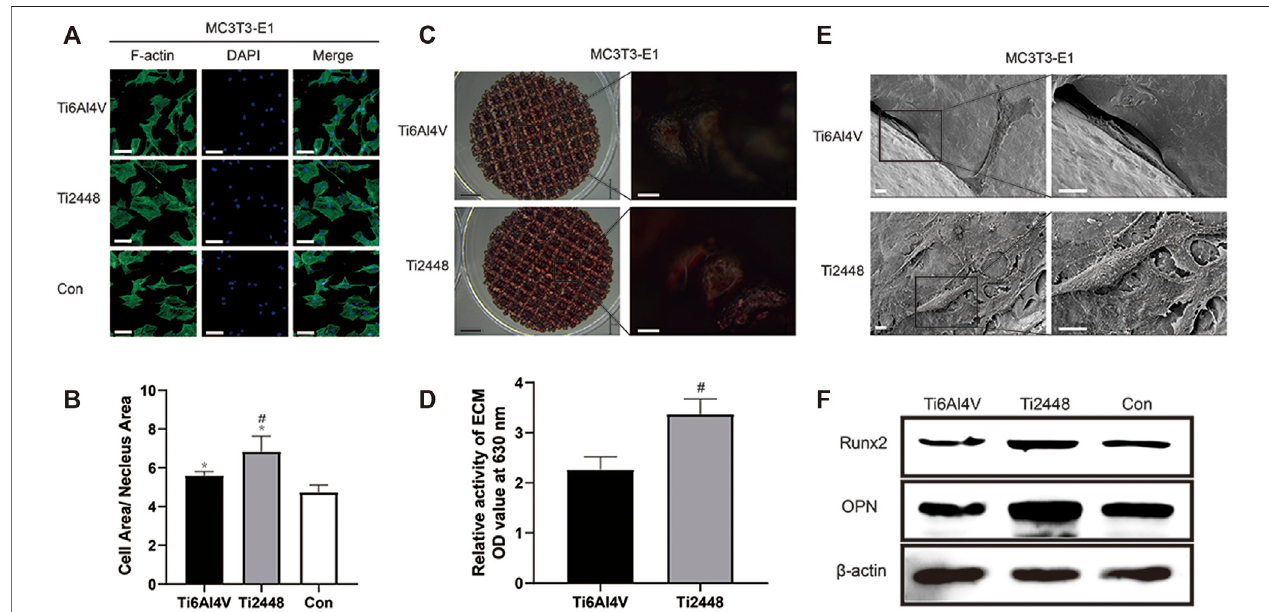
FIGURE10| EffectsofdifferentscaffoldsontheosteogeniceffectonMC3T3-E1cellsbyregulatingthepolarizationofmacrophages.Immuno fl uorescencestaining forexaminationofthecytoskeletonofMC3T3-E1cellsandevaluationofthecellmorphology.Scalebar (cid:2) 100 µm (A) .Quantitativeanalysisofthecellarea/nuclearareain different groups (B) . Examination of mineralized nodules on different scaffolds by stereoscopy to evaluate the osteogenic effect. Scale bars: black (cid:2) 2 mm, white (cid:2) 100 µm (C) . Semiquantitative analysis of mineralization in cells cultured on different scaffolds (D) . Observation of the morphology, adhesion and spreading of MC3T3-E1 cells on different scaffold surfaces by SEM. Scale bar (cid:2) 100 µm (E) . Western blot analysis of the expression levels of Runx2 and OPN in different groups (F) . Note: * p ＜ 0.05 compared to the control; # p ＜ 0.05 compared to